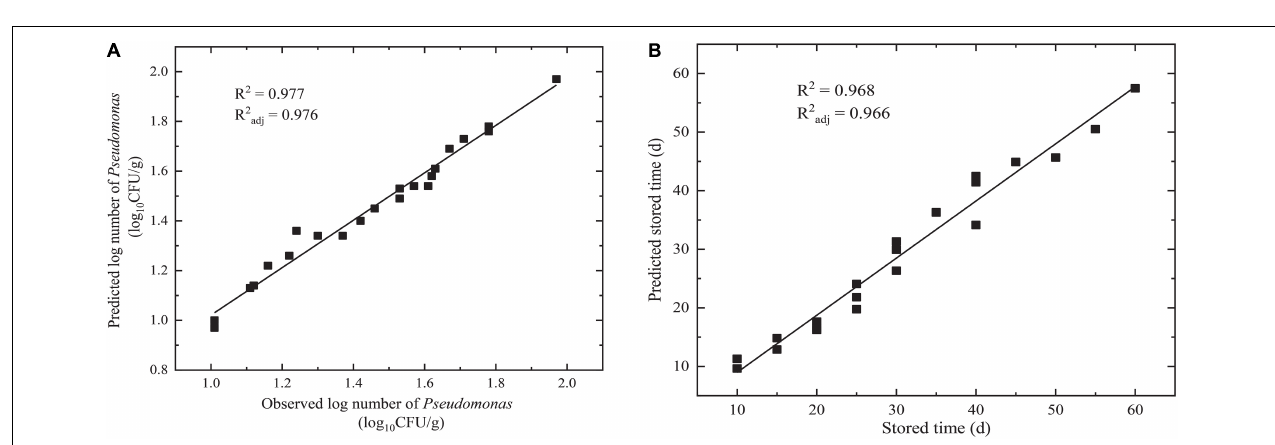
FIGURE 3 | Linear fit for observed and predicted numbers based on DAM for NGB from internal data. (A) Observed and predicted numbers of Pseudomonas ; (B) Observed and predicted storage time.